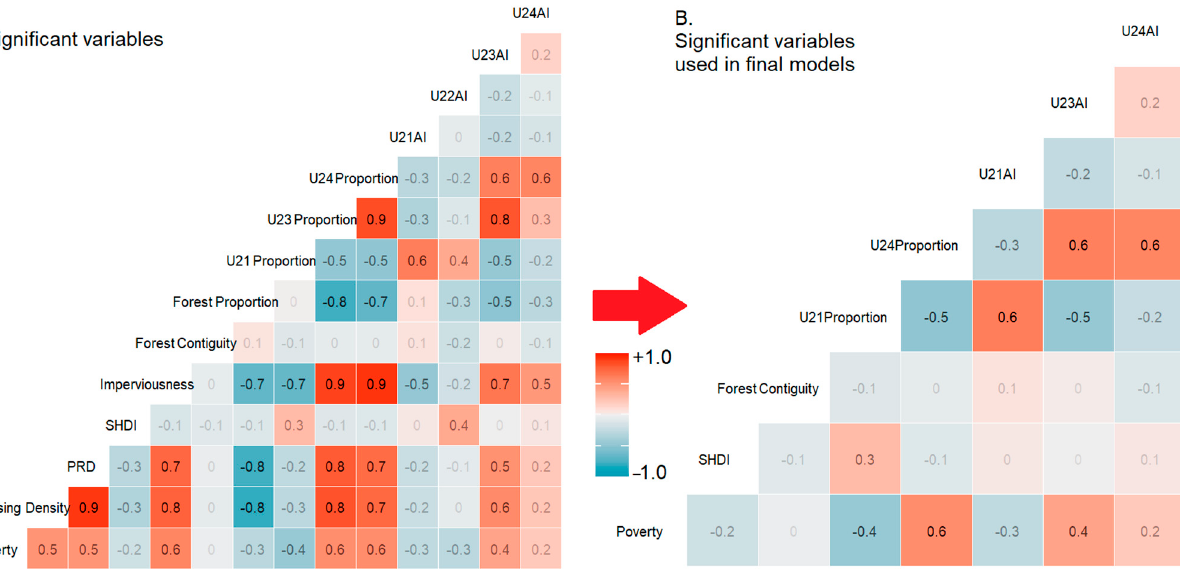
Figure 3. Correlation matrix before and after reduction of significant variables: ( A ) All significant variables based on the univariate models; ( B ) Reduced set of significant variables used in final multivariate models. (Note: Land cover classes are based on the reclassified NLCD raster: U21 = Open, U22 = Low, U23 = Medium, U24 = High intensity developed lands). AI = Aggregation Index, SHDI = Shannon Diversity Index, CI = Contiguity Index, PRD = Patch Richness Density.